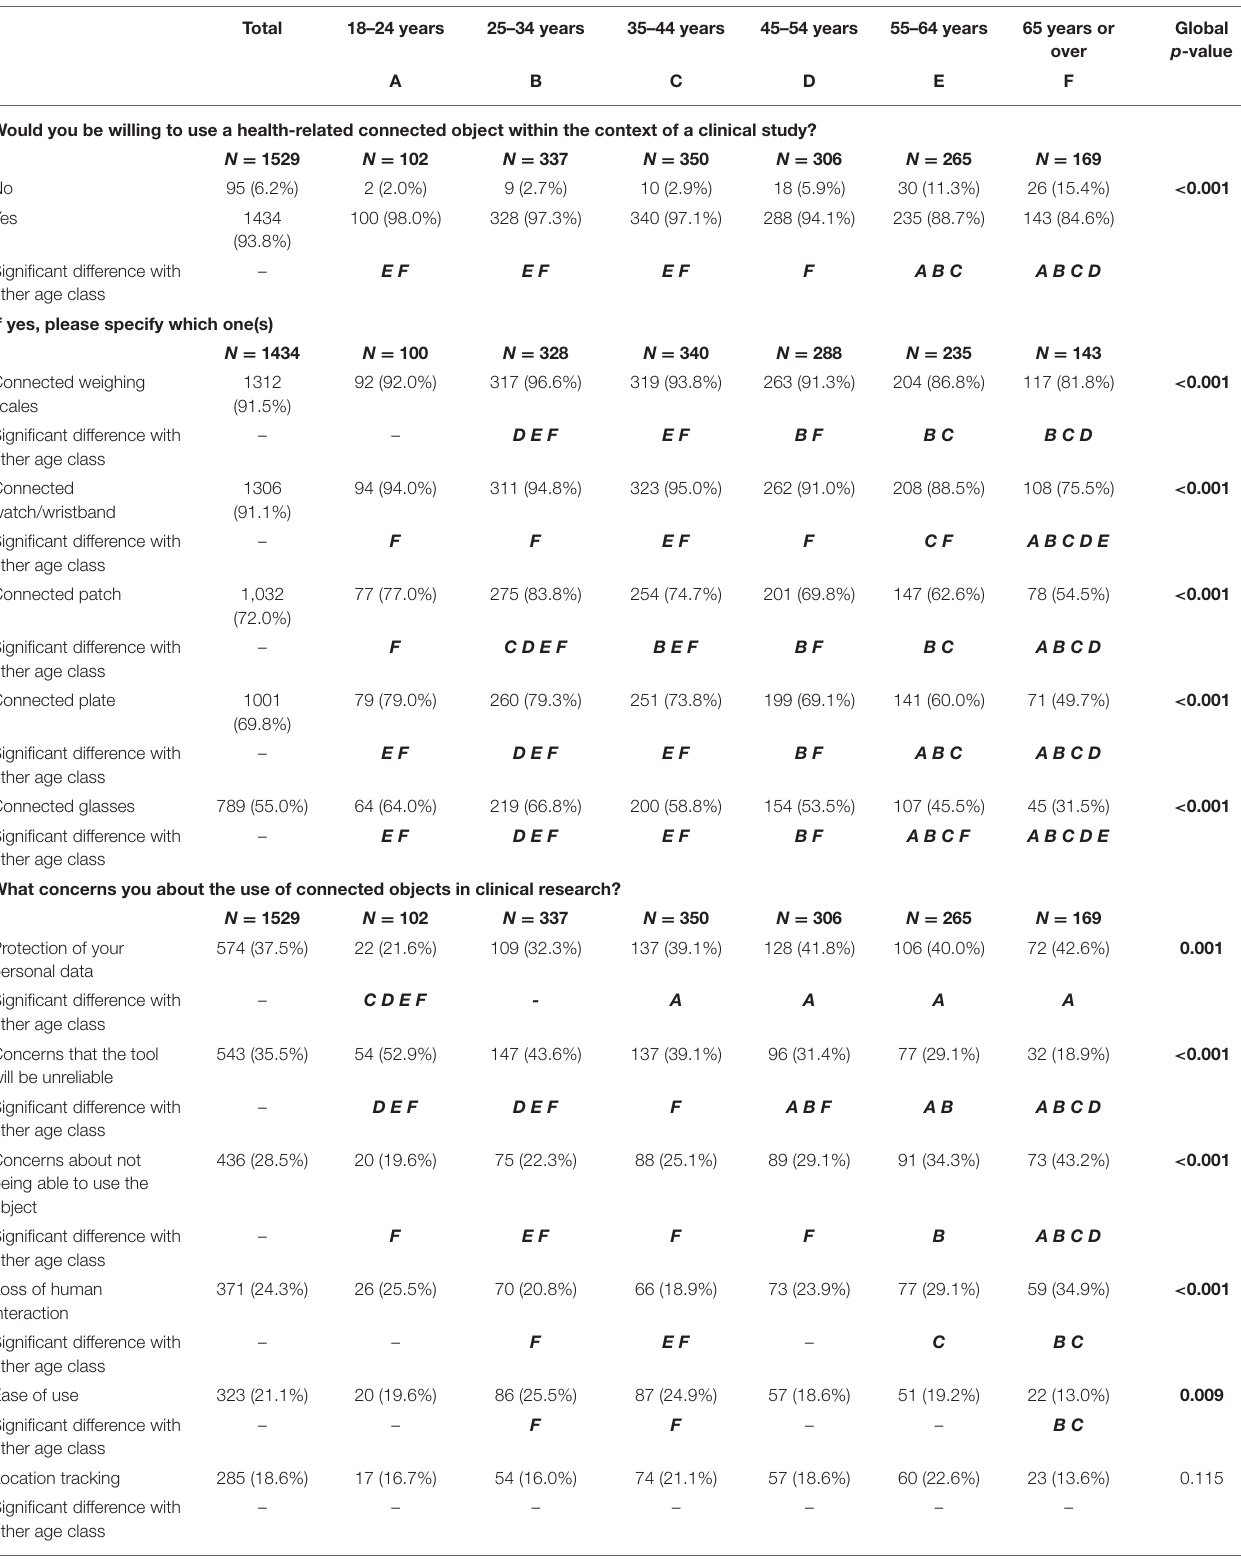
TABLE 5 | Use of connected devices and social media enabled features in clinical research by age